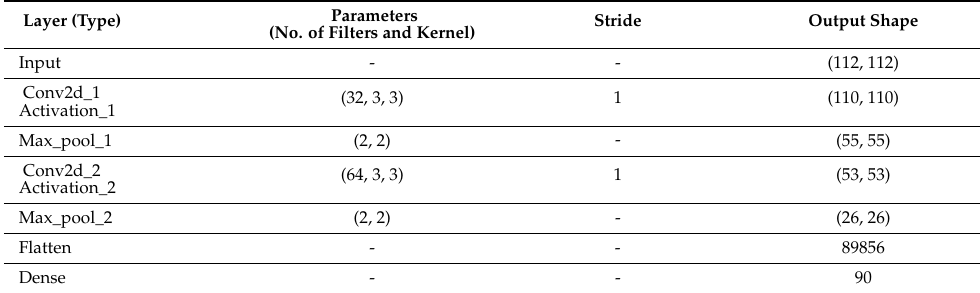
Table 2. Layers and parameters of the Siamese network.